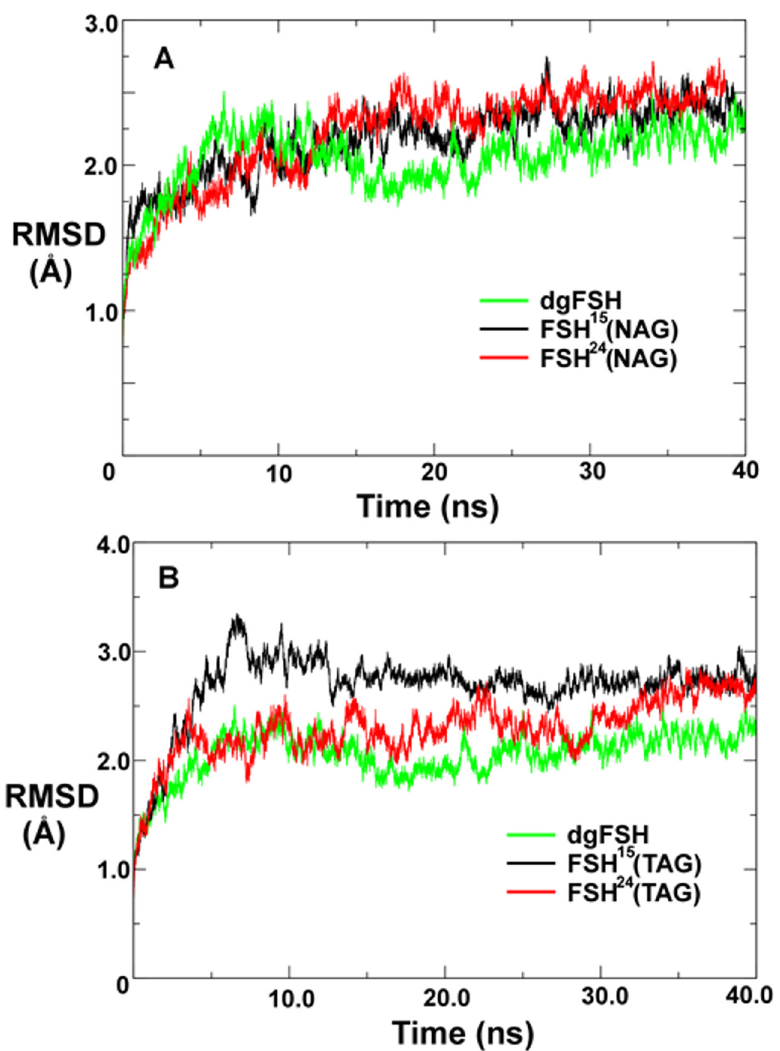
Fig 4. Root mean-squared positional deviation among FSH protein backbone atom positions during molecular dynamics simulations computed relative to the original X-ray crystallographic coordinates. A . Comparison of FSH glycoforms decorated with single NAG residues. B . Comparison of FSH glycoforms decorated with TAG oligosaccharides.